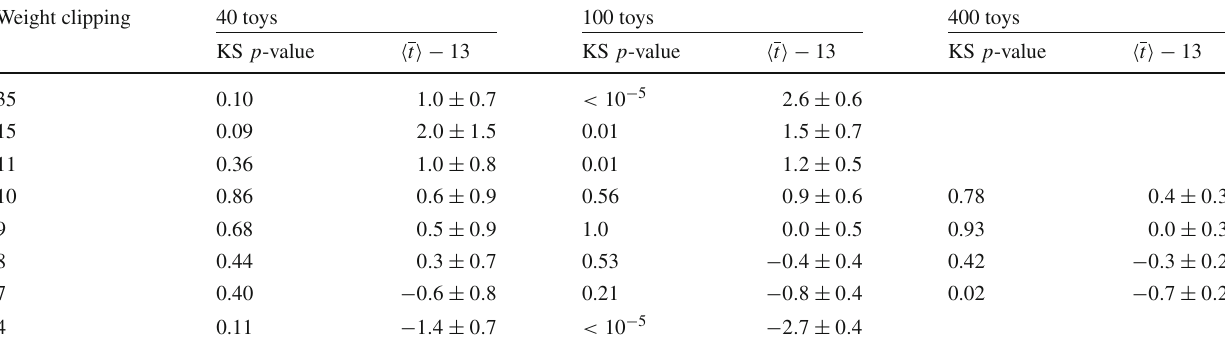
Table 1 Kolmogorov–Smirnov p -value and average t (minus the expected mean of 13) for the ( 1 , 4 , 1 ) network trained over samples of 40, 100 and 400 toy datasets, for different values of the weight clipping regularization parameter Weight clipping 40